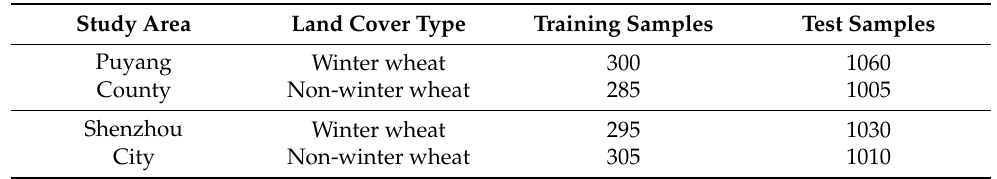
Figure 2. Distribution of samples in Puyang County ( a ) and Shenzhou City ( b ). Table 2. The number of samples in the study